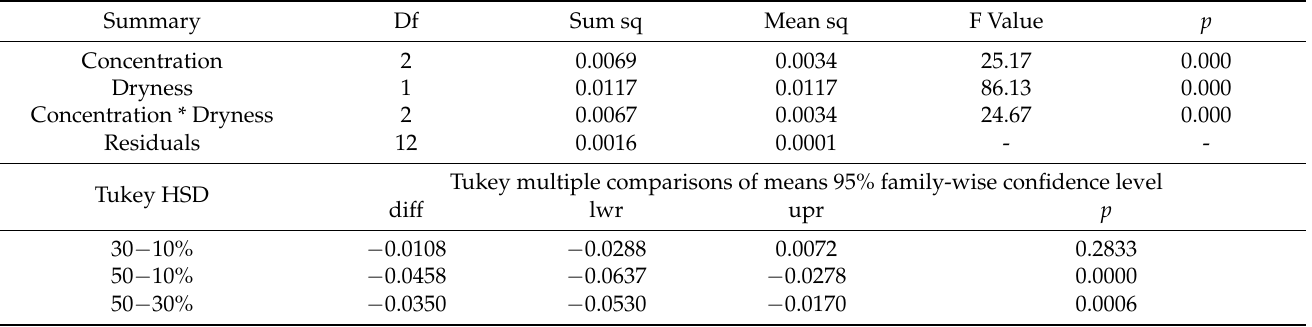
Table 9. Summary of factor importance and Tukey HSD results (JIS).